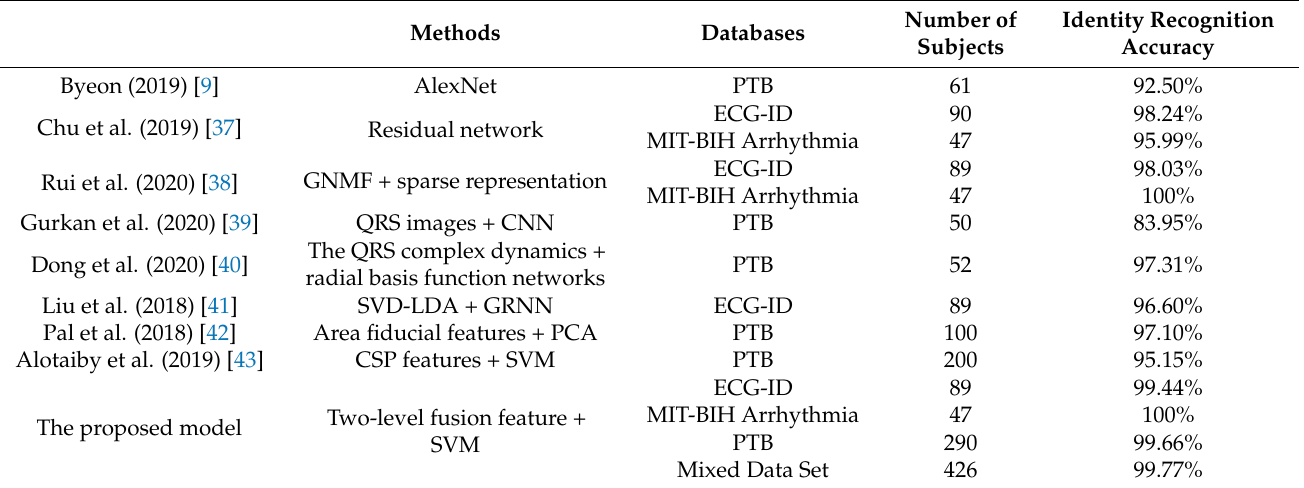
Table 4. Comparison for identification results of different